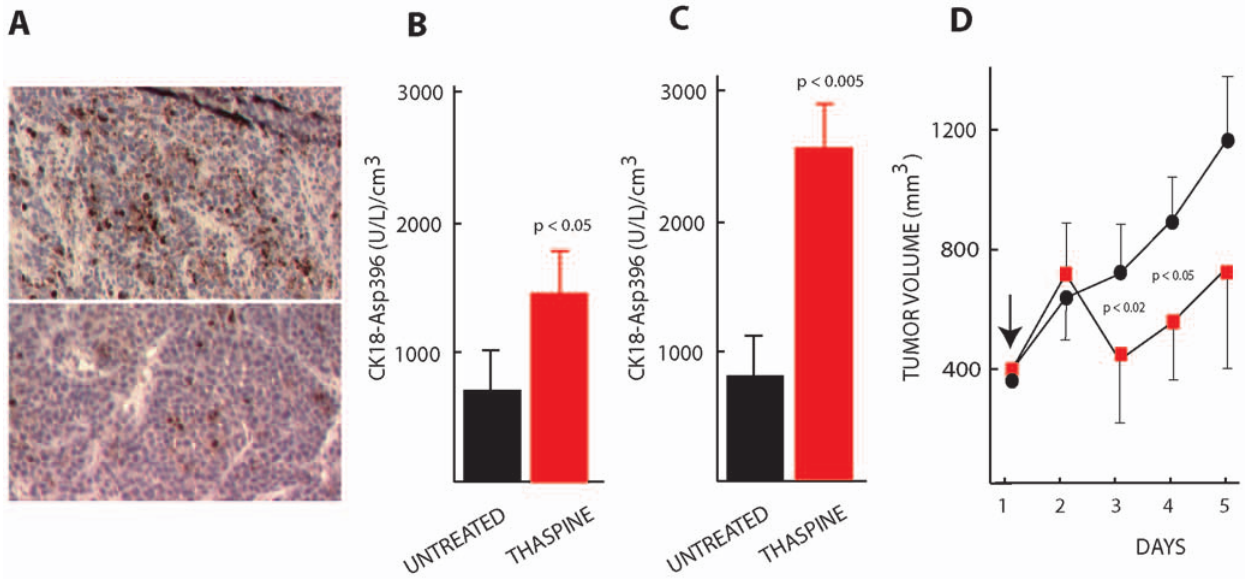
Figure 2. Invivo induction of tumor apoptosis by thaspine. (A) Induction of apoptosis in HCT116 tumors in vivo . SCID mice were injected with 10 mg/kg thaspine. Mice were sacrificed after 48 hours and tumors stained for active caspase-3 (upper panel: thaspine treated mice; lower panel: PBS injected mice). (B, C) SCID mice carrying HCT116 tumors (B) or FaDu head-neck carcinoma tumors (C) were injected with 10 mg/kg of thaspine or with PBS and the levels of human caspase-cleaved CK18 (CK18-Asp396) were determined in mouse plasma 48 hours after treatment using ELISA. The antibodies used to detect CK18-Asp396 do not bind mouse CK18. Four mice in each group; bars represent S.D. (D) SCID mice carrying FaDu tumors were treated with 10 mg/kg of thaspine (day 1, arrow) and tumor volume was calculated; black circles: untreated mice, red squares: treated mice (4 mice in each group). Error bars are presented as unidirectional for figure clarity. Animals were sacrificed when tumors were approximately 1 cm 3 according to local animal welfare regulations. Statistical significance was calculated using Student’s